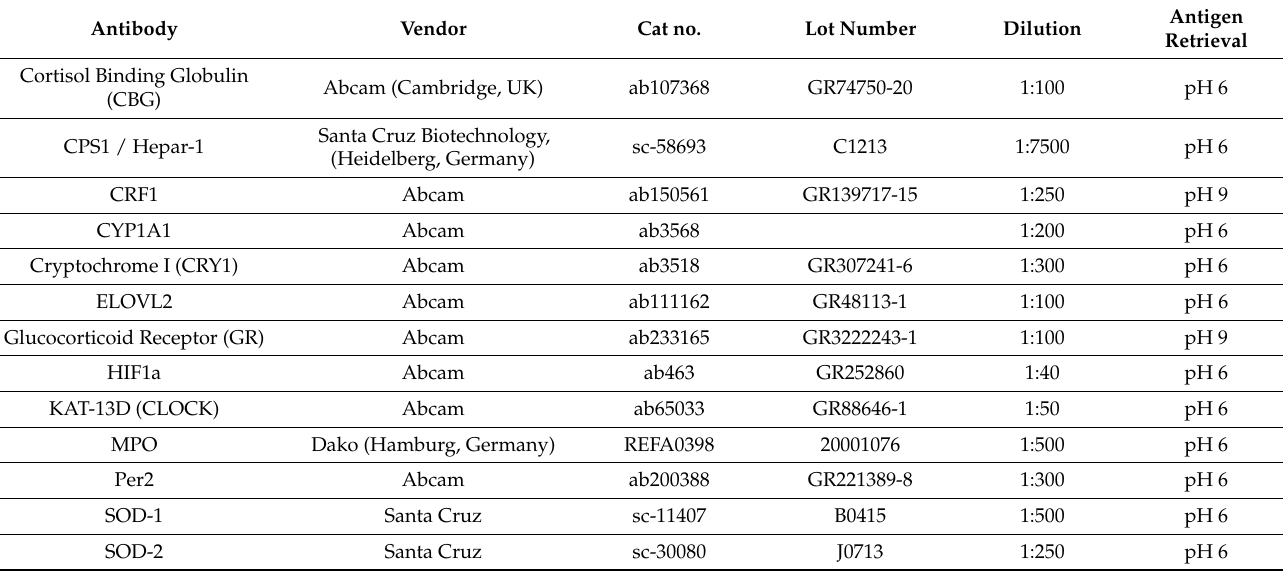
Table 9. Antibodies used for